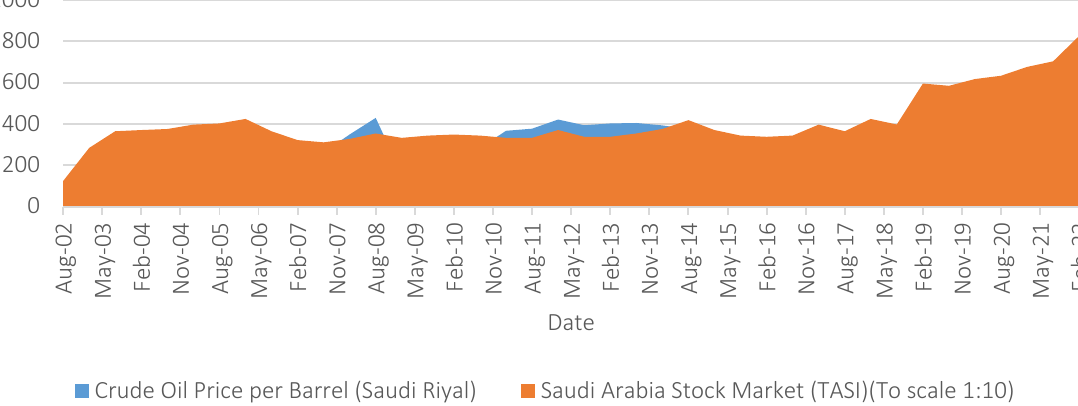
Figure 2. Comparison of Saudi Arabian crude oil prices and financial market performance to reduce price